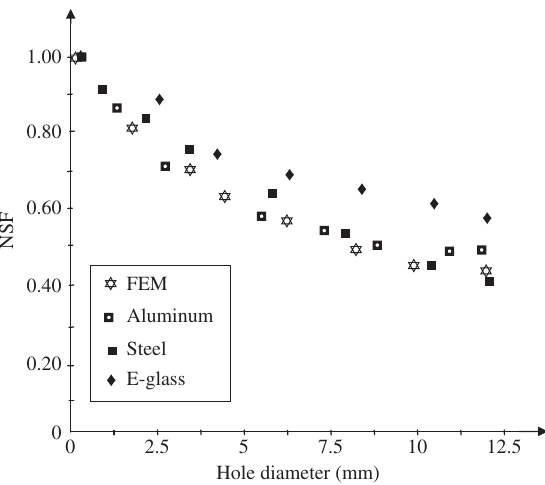
Figure 5 Comparison of NSF in tension for bonded reinforcements.